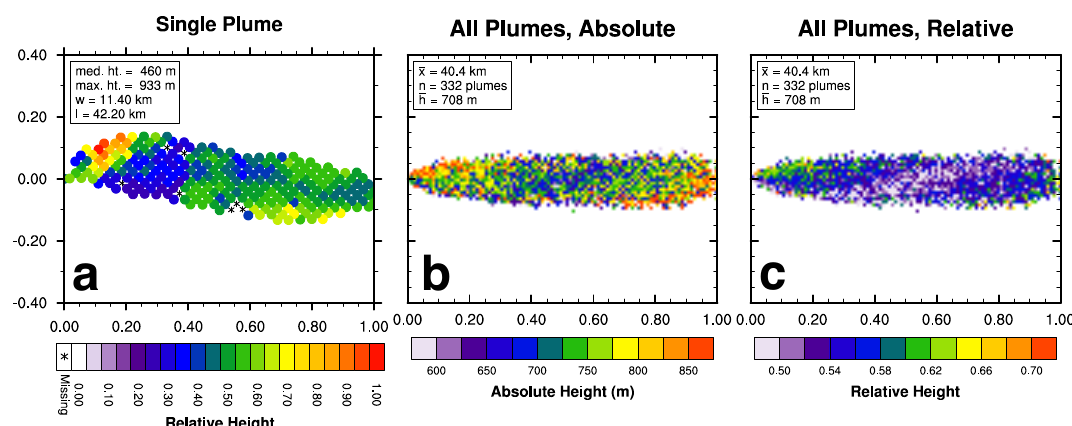
Fig. 7. (a) Relative (to maximum) plume height for the first plume from 2001, a representative plume in terms of height trends. (b) Absolute and (c) relative plume height for the mean plume (fraction > 0 . 05), constructed as in Fig. 6b,